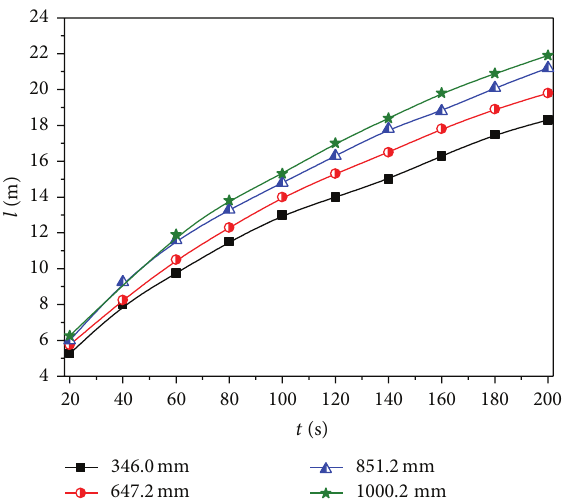
Figure 8: The gas mixture length varied with time in pipes of different diameters.